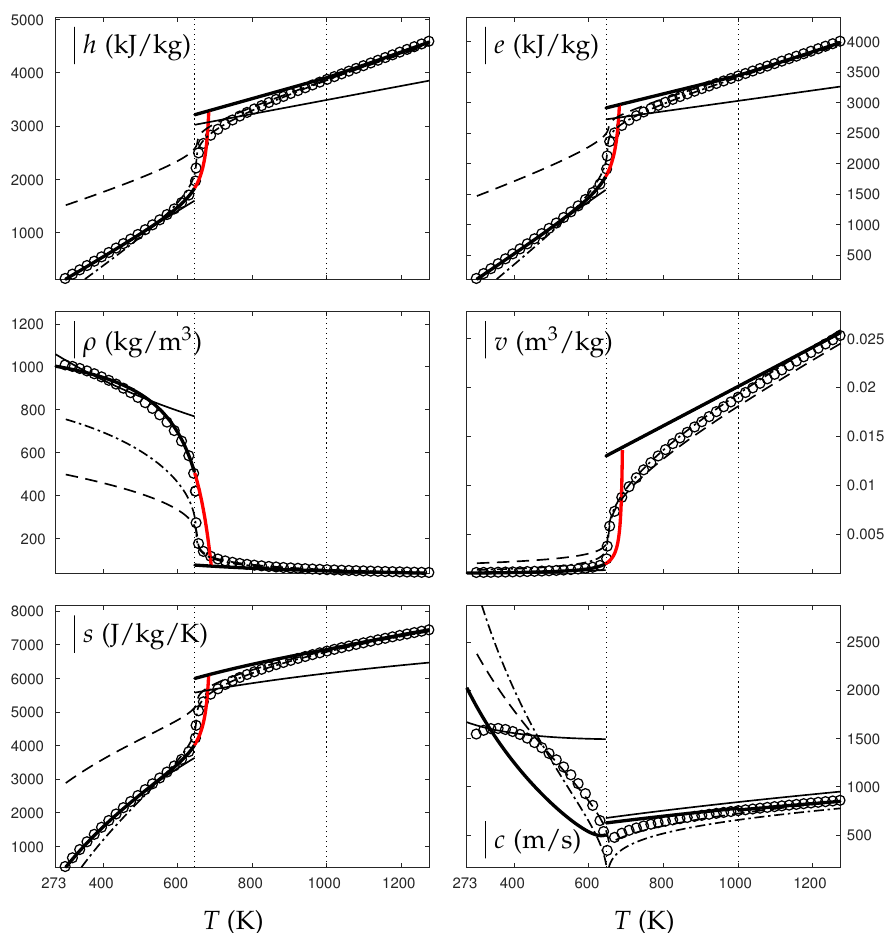
Figure 4. Comparison between experimental and theoretical isobar for water. The symbols represent the experimental isobar p = 230 bars. Beyond the critical temperature T c = 646 K, the liquid transforms to supercritical state. The thick solid lines represent the Extended NASG (ENASG) EOS, reducing to the ideal gas description for the supercritical phase, Equations (56), (57) and (60). The thin solid lines represent the original NASG EOS also reducing to the ideal gas formulation for the supercritical phase. The dashed lines represent the van der Waals (VdW) theoretical predictions and the dashed-dotted lines represent the Soave–Redlich–Kwong (SRK) ones. The critical temperature is indicated with the dotted lines. From this temperature, the liquid ENASG EOS is extended and joins the ideal gas EOS (except for the sound speed). The temperature T 0 = 1000 K at which variable heat capacities are considered is indicated in dotted lines as well.